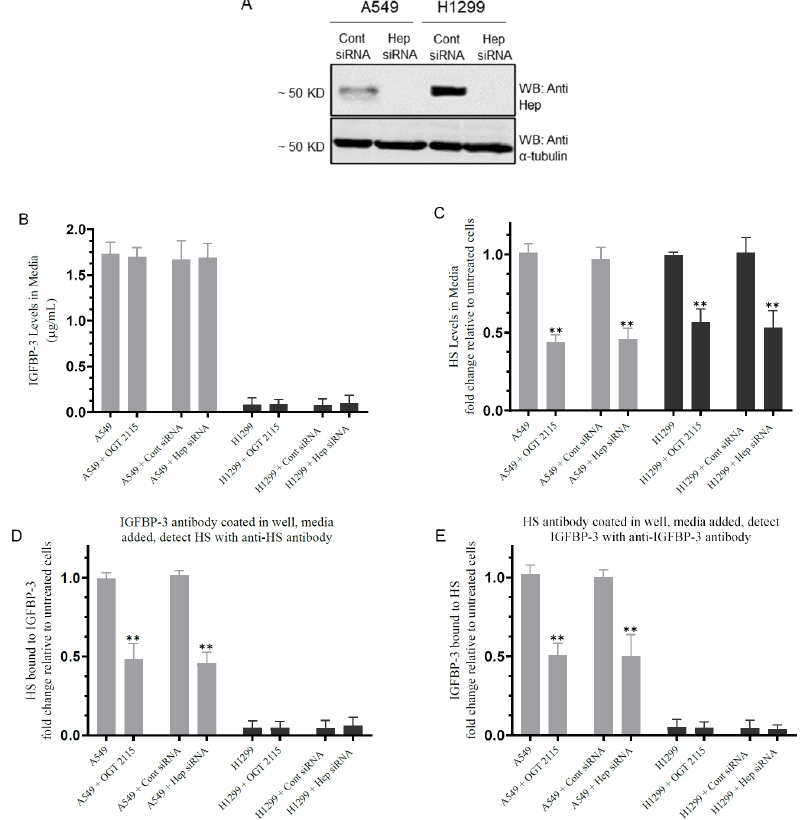
Figure 2. Blocking heparanase activity or expression using siRNA decreased HS level in the media and the amount of IGFBP-3 bound to HS. Cells (0.2 × 10 5 ) were grown in 10% FBS-supplemented media for 24 h. The following day, the cell monolayers were incubated in serum-free media for 24 h, then treated as indicated for 72 h with OGT 2115 (100 µM) or with siRNA as described in the Methods section. The same concentration of total protein (15 µL of 600 µg/mL) of the cell lysates ( A ) was used for Western blotting using the indicated antibodies. As a loading control, anti α -tubulin antibodies were used. The levels of IGFBP-3 ( B , E ) and HS ( C , D ) were measured on the same amount of protein (3 µL of 600 µg/mL total protein) in the media as described in the Materials and Methods section. The graphs summarize the results expressed as means ± SD ( n = 5) using the GraphPad 9.4.1 software. Asterisks indicate a statistically significant difference from the corresponding samples without inhibitor treatment or those treated with control siRNA of each cell line as indicated, Mann–Whitney test. The absence of asterisks indicates no significance, ** p < 0.0l.